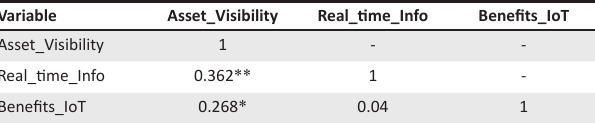
TABLE 5: Correlations of drivers and benefits of IoT.